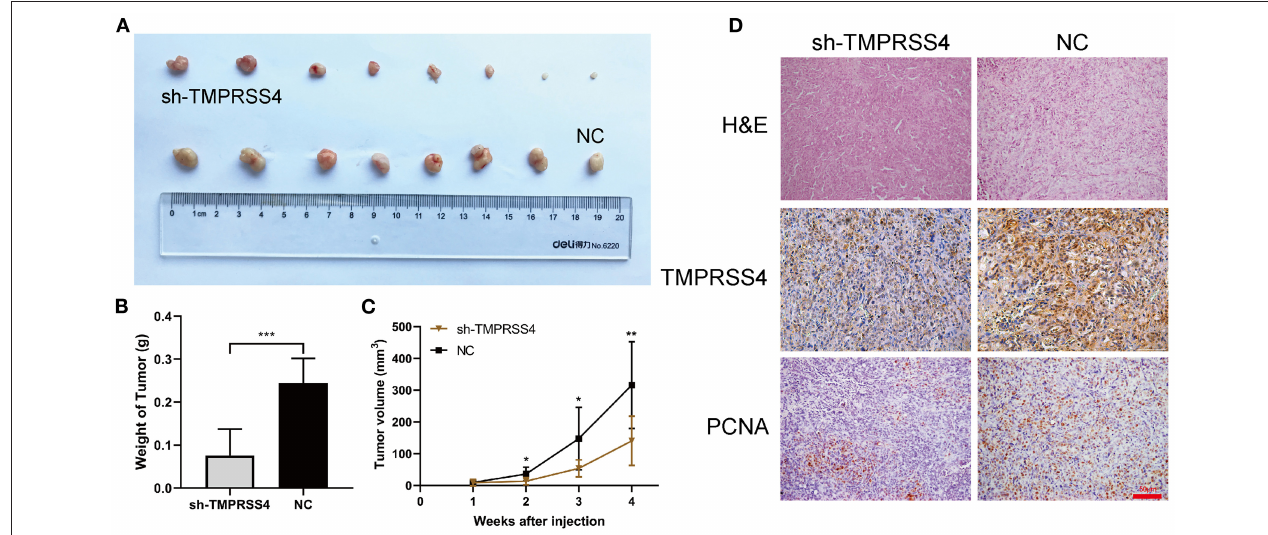
FIGURE 3 | TMPRSS4 promoted the pancreatic cancer cell proliferation in vivo . Two groups of BALB/c nude mice were subcutaneously inoculated with 5 × 10 6 AsPC-1/negative control or AsPC-1/TMPRSS4-shRNA cells. (A,B) TMPRSS4 knockdown reduced tumor size as compared to the control group. (C) Tumor volumes measured on the indicated days. The tumor length (L) and width (W) were monitored every week using a digital Vernier caliper. And the tumor volume was determined using the equation (L*W ² )/2. Data were presented as the mean ± standard deviation of tumor volume in two groups and analyzed with Student’s t -test. (D) HE and IHC staining on tumor tissues. 200x. Each bar represents the mean ± SD. * P < 0.05; ** P < 0.01; *** P < 0.001. HE, Hematoxylin and Eosin; IHC, immunohistochemistry; PCNA, Proliferating Cell Nuclear